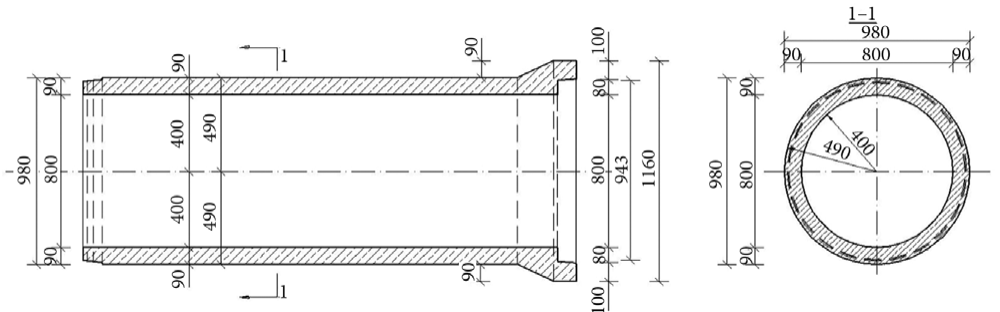
Fig. 1. The analysed reinforced concrete pipes